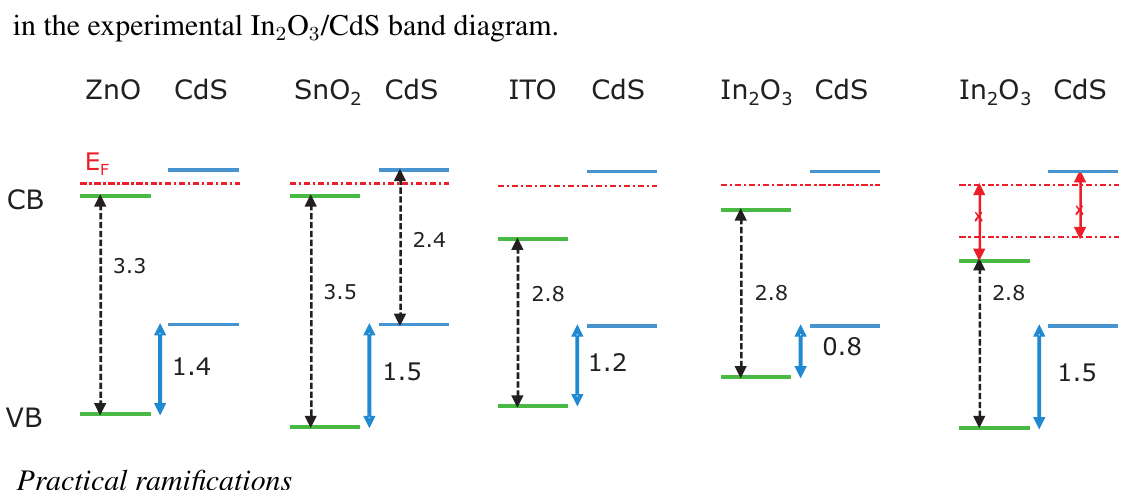
Figure 5. Energy band alignment at TCO/CdS interfaces as determined from photoelectron spectroscopy using stepwise deposition experiments and sputter depth profiles. All